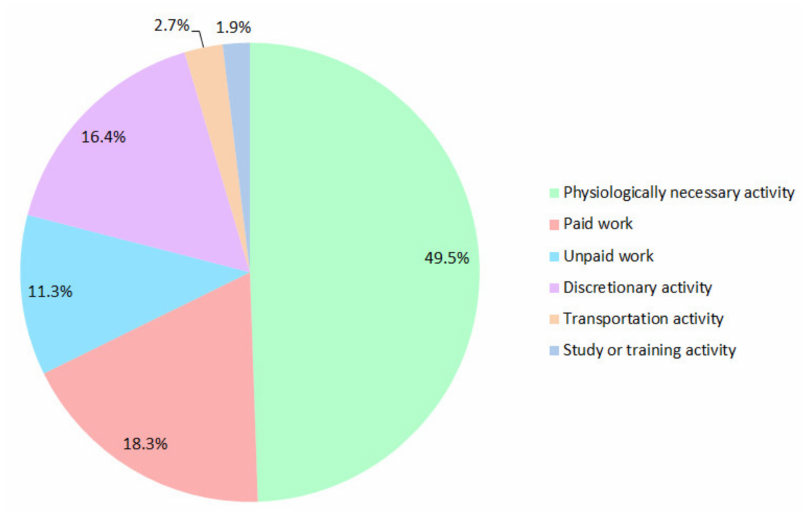
Figure 2. Time composition of residents’ daily